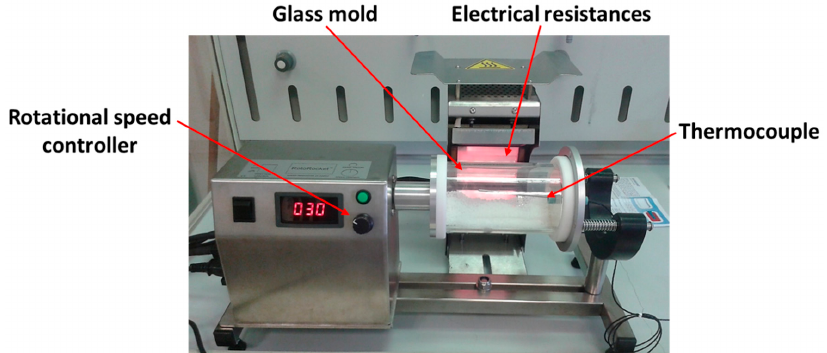
Figure 1. Uniaxial benchtop rotomachine.